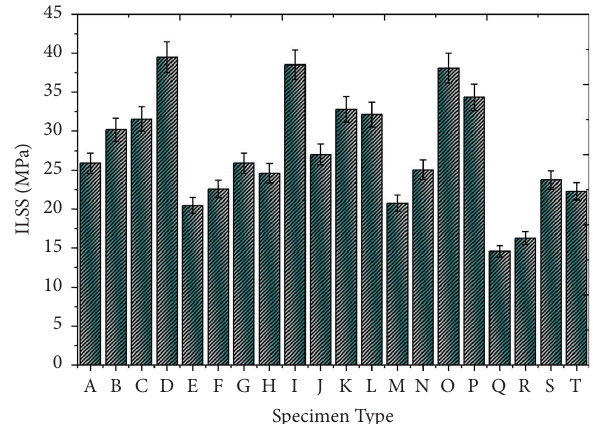
Figure 6: Bending strength of biosynthesised Al epoxy hybrid